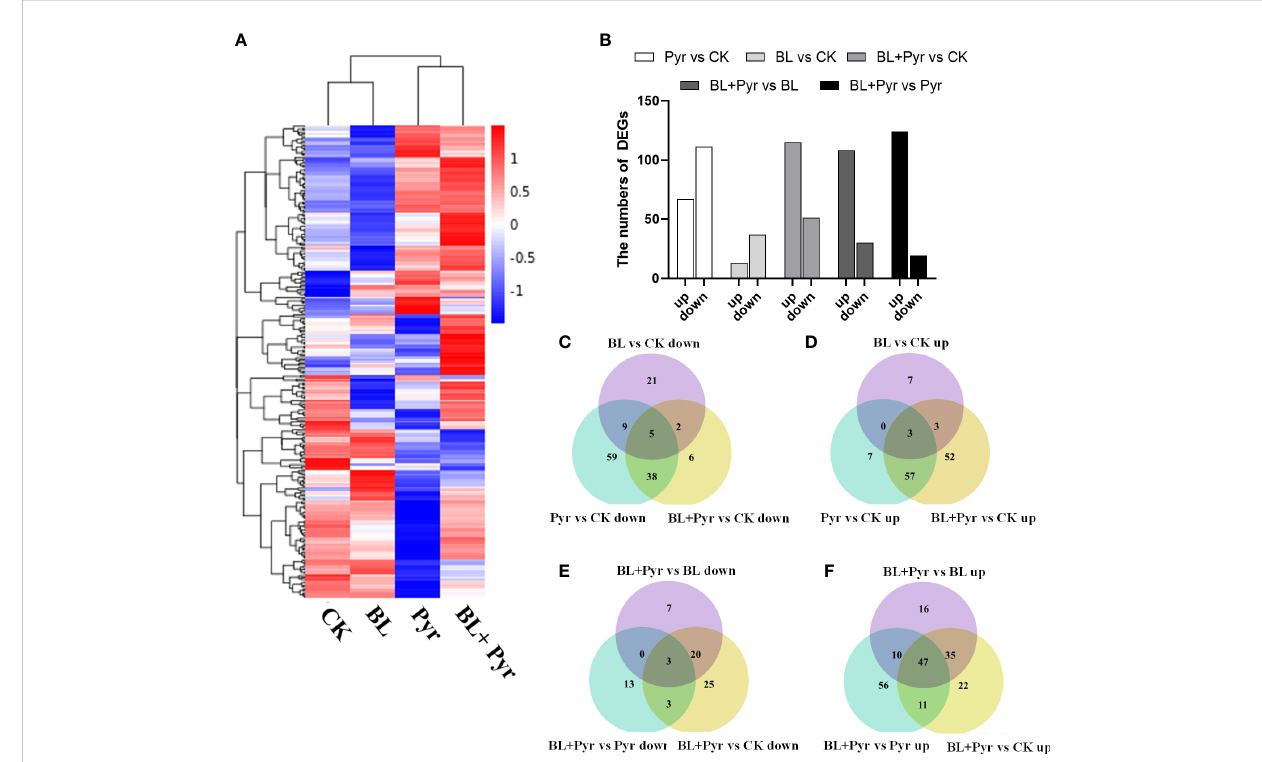
FIGURE 6 BL+Pyr activated the transcription of genes related to photosynthesis. (A) Hierarchical cluster analysis of the differentially expressed genes (DEGs) involved in photosynthesis according to the average FPKM (expected number of Fragments Per Kilobase of transcript sequence per Millions base pairs sequenced) of 3 biological repeats; (B) The number of photosynthesis-related DEGs among the comparisons. ‘ up ’ represented up-regulated and ‘ down ’ represented down-regulated. (C-F) Venn diagrams showing the overlapping and non-overlapping (DEGs) related to